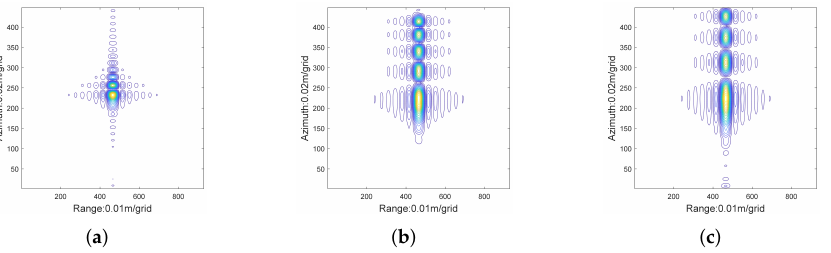
Figure 21. Two-dimensional point spread functions of scene center of different unmeasurable motion error with coefficients ( a ) A 1 = A 2 = A 3 = 0.001, ( b ) A 1 = A 2 = A 3 = 0.01 and ( c ) A 1 = A 2 = A 3 = 0.02.